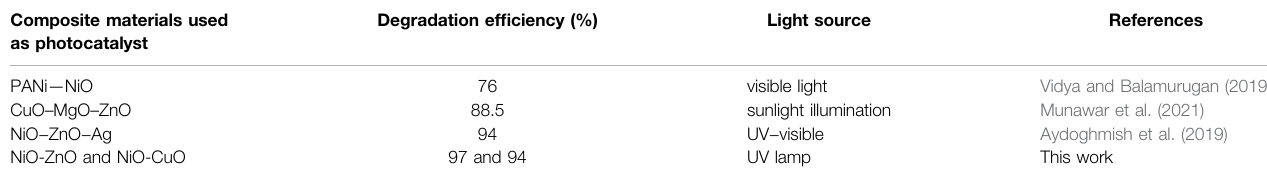
TABLE 3 | Comparison of photocatalytic performance of materials toward the degradation of methylene blue. Composite materials used as